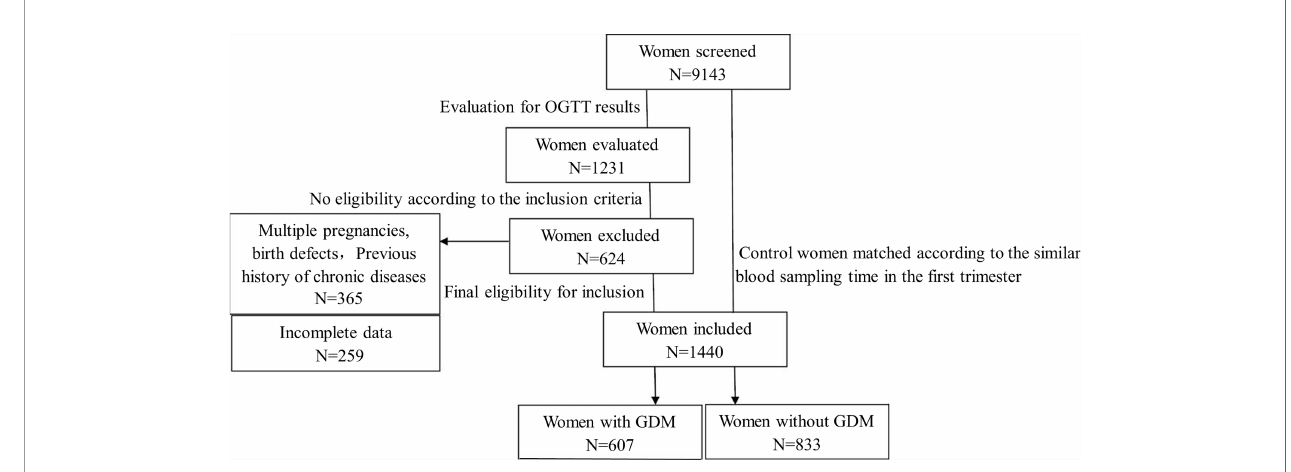
FIGURE 1 | Schematic study work fl